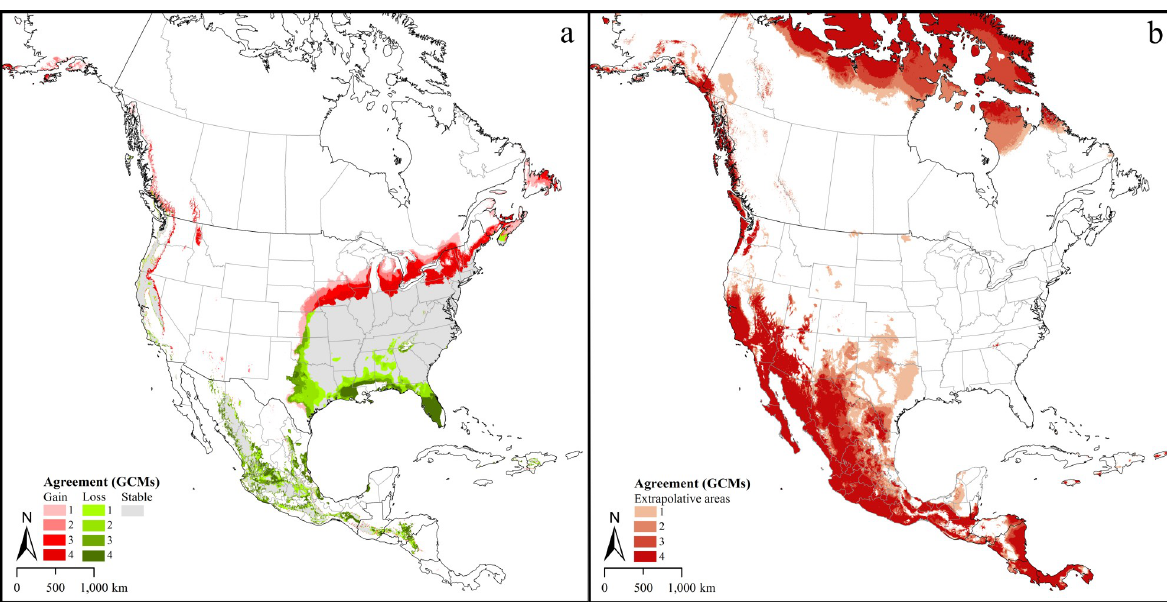
Fig 3. Predicted future suitable regions under climate change scenarios. a. Predictions under the Representative Concentration Pathway (RCP) 4.5, and agreement between different Global Circulation Models. 1 = areas in which one of the four GCMs predicted suitability for Amblyomma americanum distribution. 2, 3, 4 = two, three and four GCMs predicted suitability, respectively. 5 = areas in which one of the four GCMs predicted loss of territory for A . americanum compared to the present-day distribution. 6, 7, 8 = two, three, and four GCMs predicted loss of territory, respectively. b. Agreement among Global Circulation Models (GCMs) in North America with strict extrapolative conditions under the low emissions, RCP 4.5 scenario. 1 = Areas in which the prediction based on one of the four Global Circulation Models (GCMs) were strictly extrapolative. 2, 3, 4 = degree of agreement in strict extrapolative areas based on two, three and all four models, respectively.